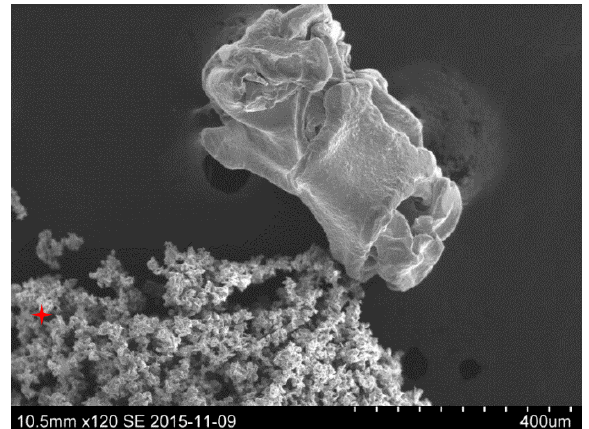
Figure 5. SEM image of leach residue with precipitate of experiment 4. Table 7. EDS results of point analysis of precipitate on the red mark on the left figure. Element